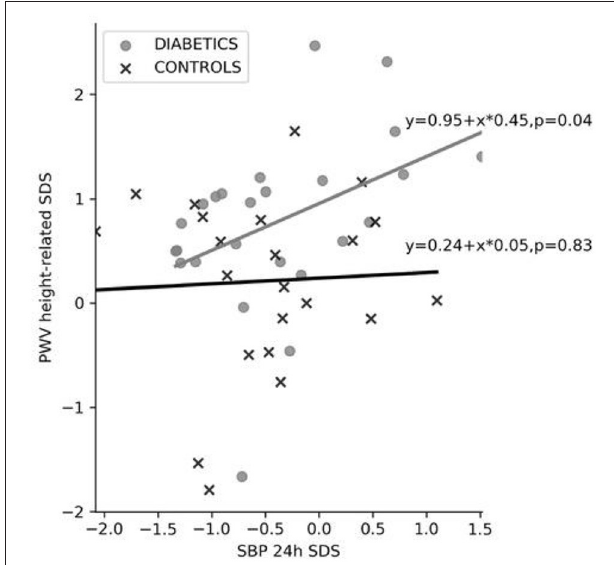
FIGURE 3 | Relationship between 24-h SBP SDS and height-related PWV SDS. PWV, pulse wave velocity; SBP 24-h SDS, 24-h systolic blood pressure standard deviation